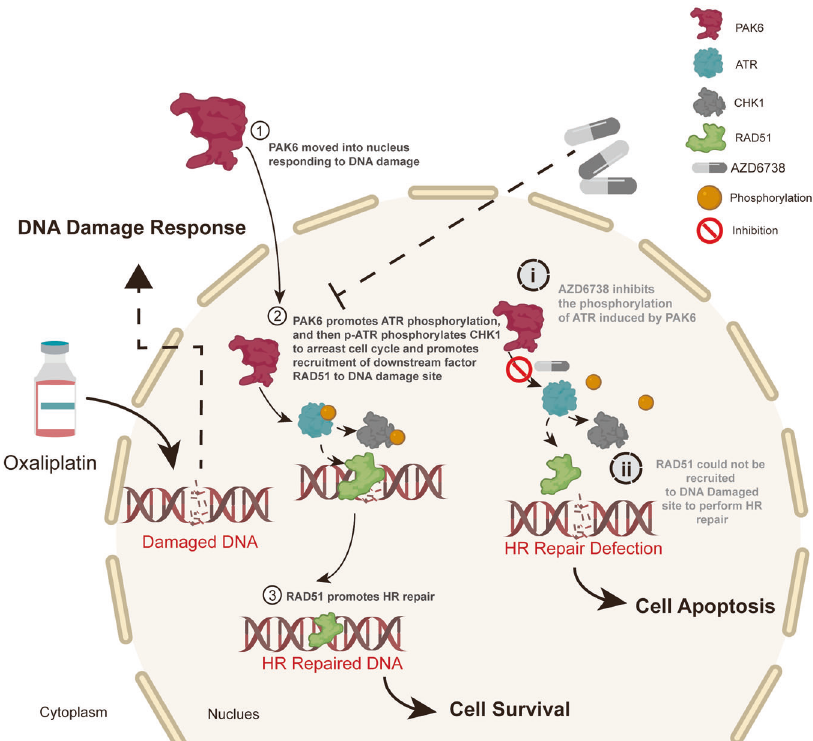
Fig. 8 A model for PAK6 induced chemoresistance to oxaliplatin in GC. In PAK6 high expression GC cells, when DSB is initiated by the treatment of oxaliplatin, PAK6 could behave as an upper DDR factor to move into nucleus from cytoplasm to promote the phosphorylation of ATR. And then the activated p-ATR could further phosphorylate CHK1 to arrest the cell cycle in G2/M phase, and promote the recruitment of RAD51 to the nucleus to perform HR repair, thereby promoting the chemoresistance to oxaliplatin, ultimately leading to cells survival. However, failure to maintain the appropriate phosphorylation of ATR after conducting AZD6738 based on oxaliplatin treatment results in de fi ciency of recruitment of RAD51 to the nucleus to perform HR repair, ultimately leading to cell apoptosis. Combination of AZD6738 and oxaliplatin could overcome the chemoresistance to oxaliplatin induced by